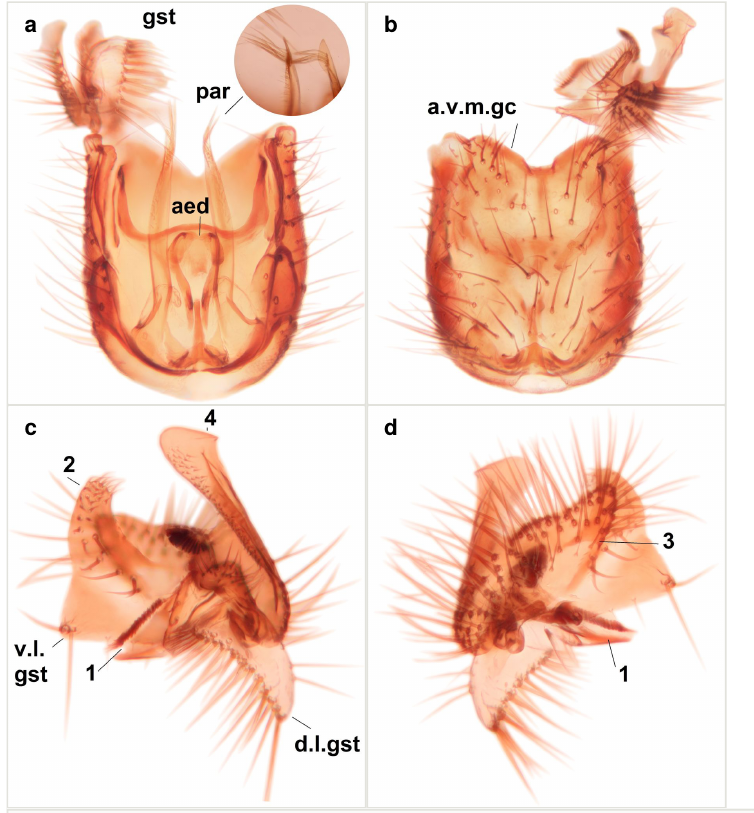
Figure 13. Phronia braueri Dziedzicki, male hypopygium. The specimen (MYCE-JS-2013-0014, JES) is collected from Finland, Lkor: Savukoski, Joutenoja, 16.8.-18.9.2012, J. Salmela leg. Please see Fig. 11 for abbreviations and